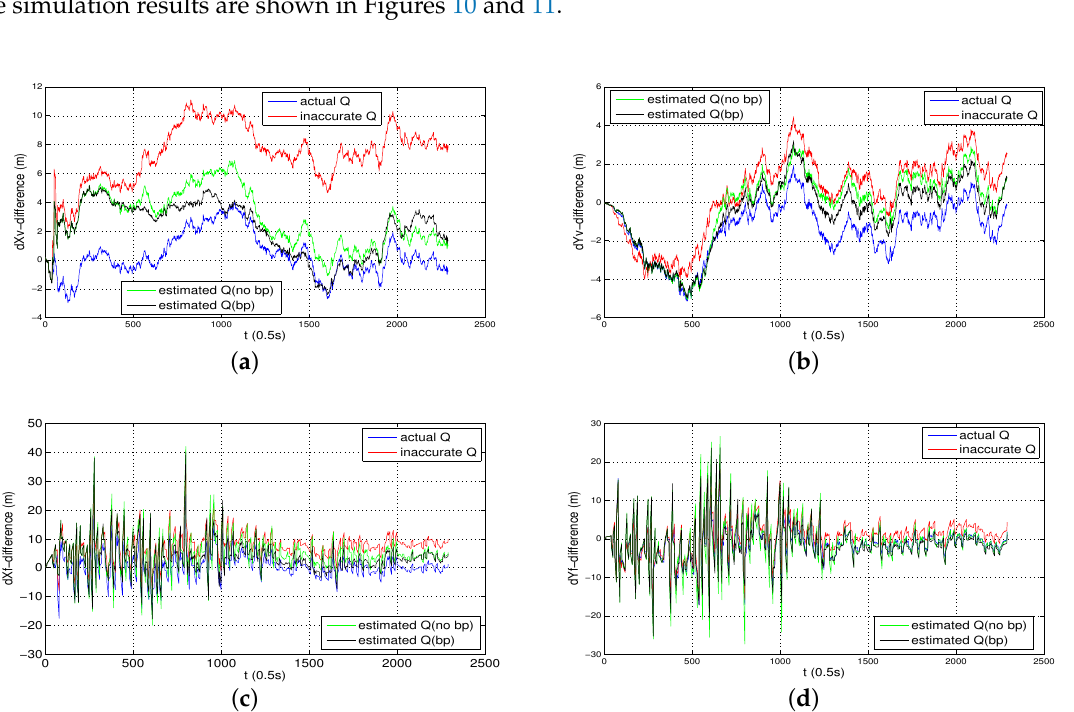
Figure 10. The positioning error of AUV and MRS, in which ( a ) illustrates the horizontal direction of the positioning error components of AUV in global frame; ( b ) illustrates the vertical direction of the positioning error components of AUV in global frame; ( c ) illustrates the horizontal direction of the positioning error components of MRS in global frame; ( d ) illustrates the vertical direction of the positioning error components of MRS in global